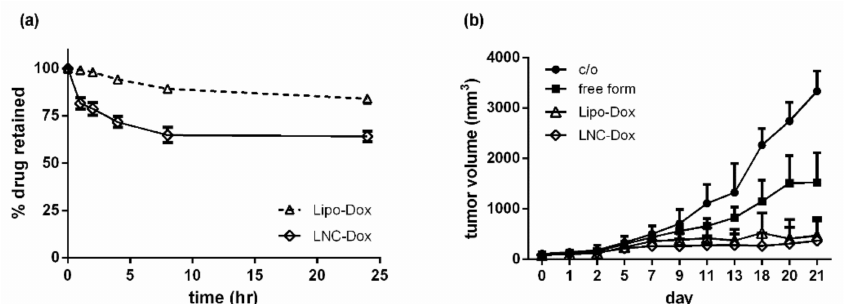
Figure 3. ( a ) In vitro serum stability of Lipo-Dox and LNC-Dox over a time period of 24 h. Data are expressed as the mean ± SD ( n = 3). ( b ) In vivo therapeutic efficacy of different doxorubicin formulations. Mice were intravenously administrated with indicated drugs (10 mg/kg) three times (day 0, day 7, and day 14) during the treatment. Data are expressed as the mean ± SD ( n = 5).